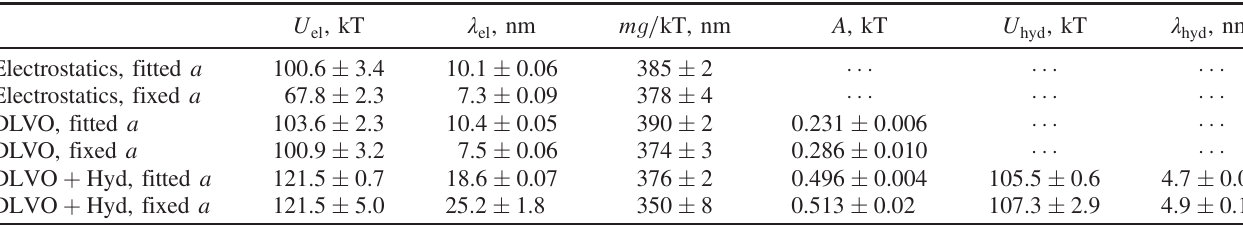
radii extracted from PERI ( “ fitted a ” ) and for each particle ’ s radius fixed to its mean value over the duration of many frames ( “ fixed a ” ). e − δ = λ el , full DLVO theory (i.e., electrostatic repulsion The interparticle potentials are as follows: pure electrostatic repulsion U ð δ Þ ¼ U el and van der Waals attraction) with Hamaker constant A , and full DLVO with an additional, short-ranged hydrophilic